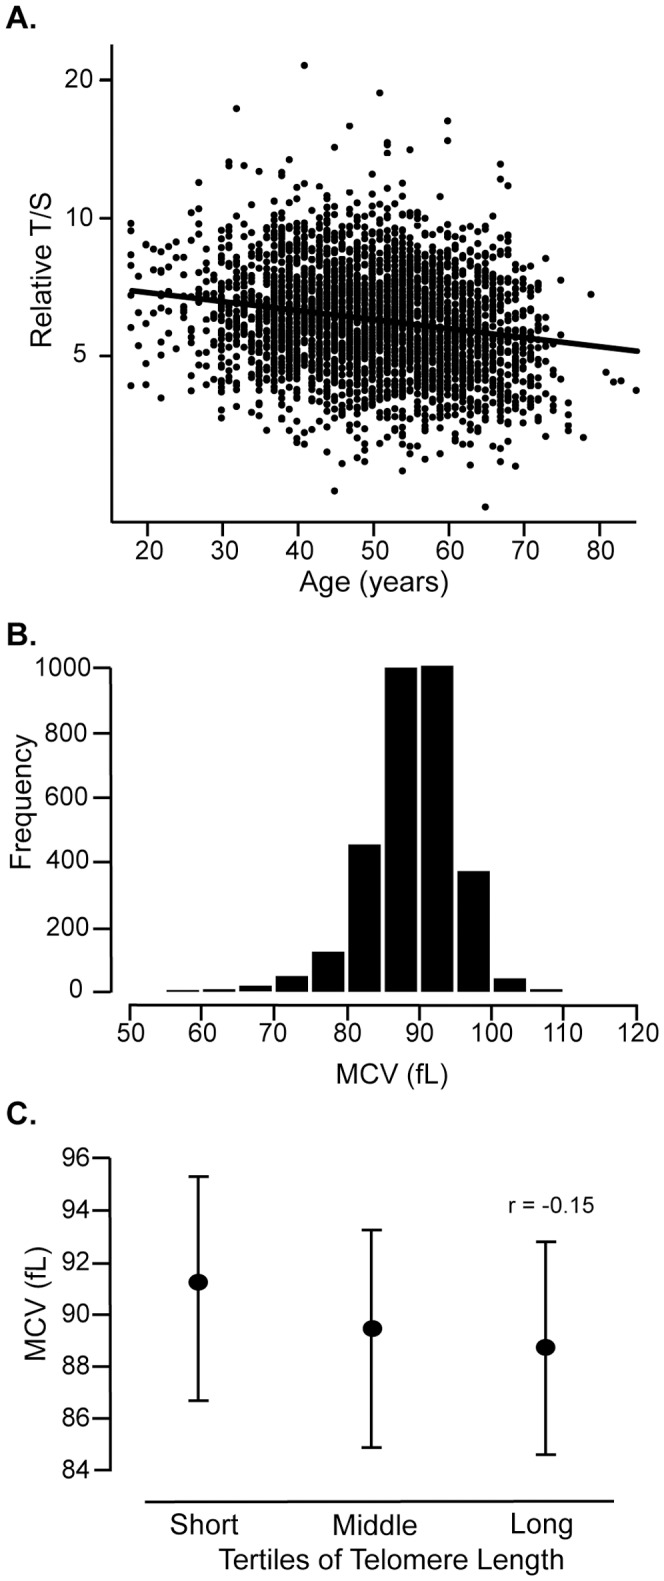
Distribution of Telomere Length and RBC Mean Corpuscular Volume of DHS2 Subjects.(A) Each dot represents a subject from the Dallas Heart Study 2 (DHS2). Telomere length is measured from genomic DNA isolated from blood leukocytes using a quantitative PCR assay, expressed as the Relative T/S ratio. The ratio of the copy number of telomere DNA (T) to a single-copy gene (S) for each subject is expressed relative to a cultured cell line (MCF7) which has very short telomere lengths (see Methods for additional details). (B) Distribution of red blood cell Mean corpuscular volume (MCV) in the DHS2 population. (C) The mean MCV for each of the telomere length tertiles is indicated by the point and the interquartile (1st through 3rd) distribution is indicated by the bars.